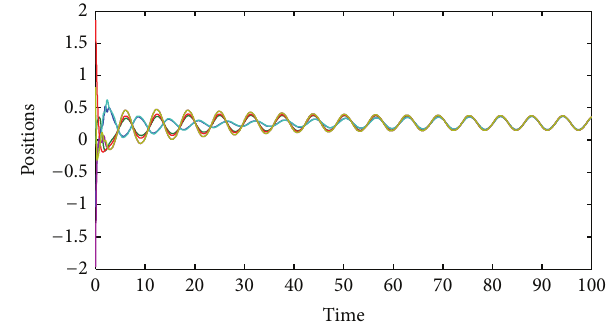
Figure 2: The trajectory of agents position states.